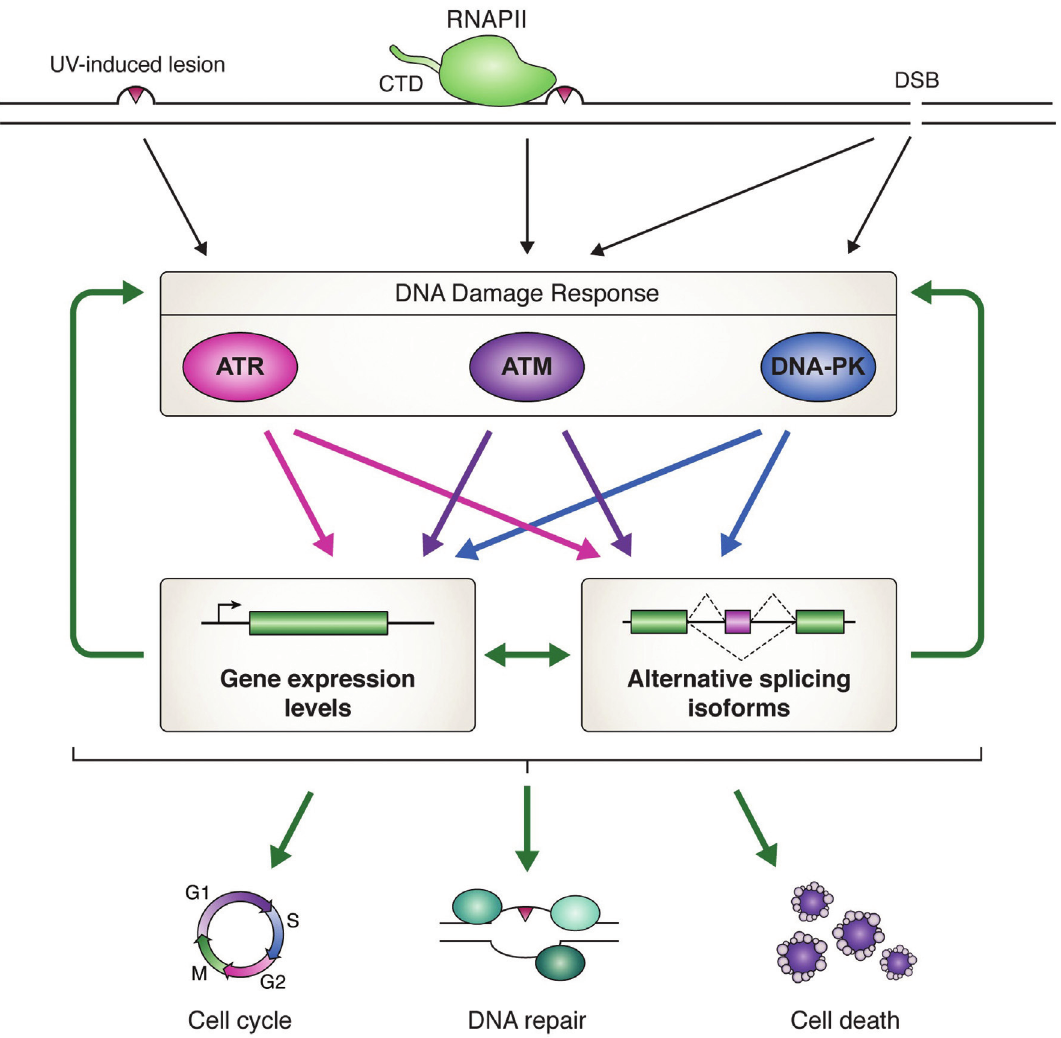
Figure1 -RolesrecentlyreportedforthekinasesATR,ATMandDNA-PKaredepicted.UV-inducedDNAlesionsactivateATRandATM,thelatterbe- ing activated in particular by stalling of transcribing RNAPII. Double strand breaks (DSB) activate ATM and DNA-PK. These three central DDR kinases modulate gene expression globally, both by regulating gene expression levels and by modifying AS patterns. This modulation, in turn, tunes the DDR by modulating cell-cycle regulation, DNA repair and cell